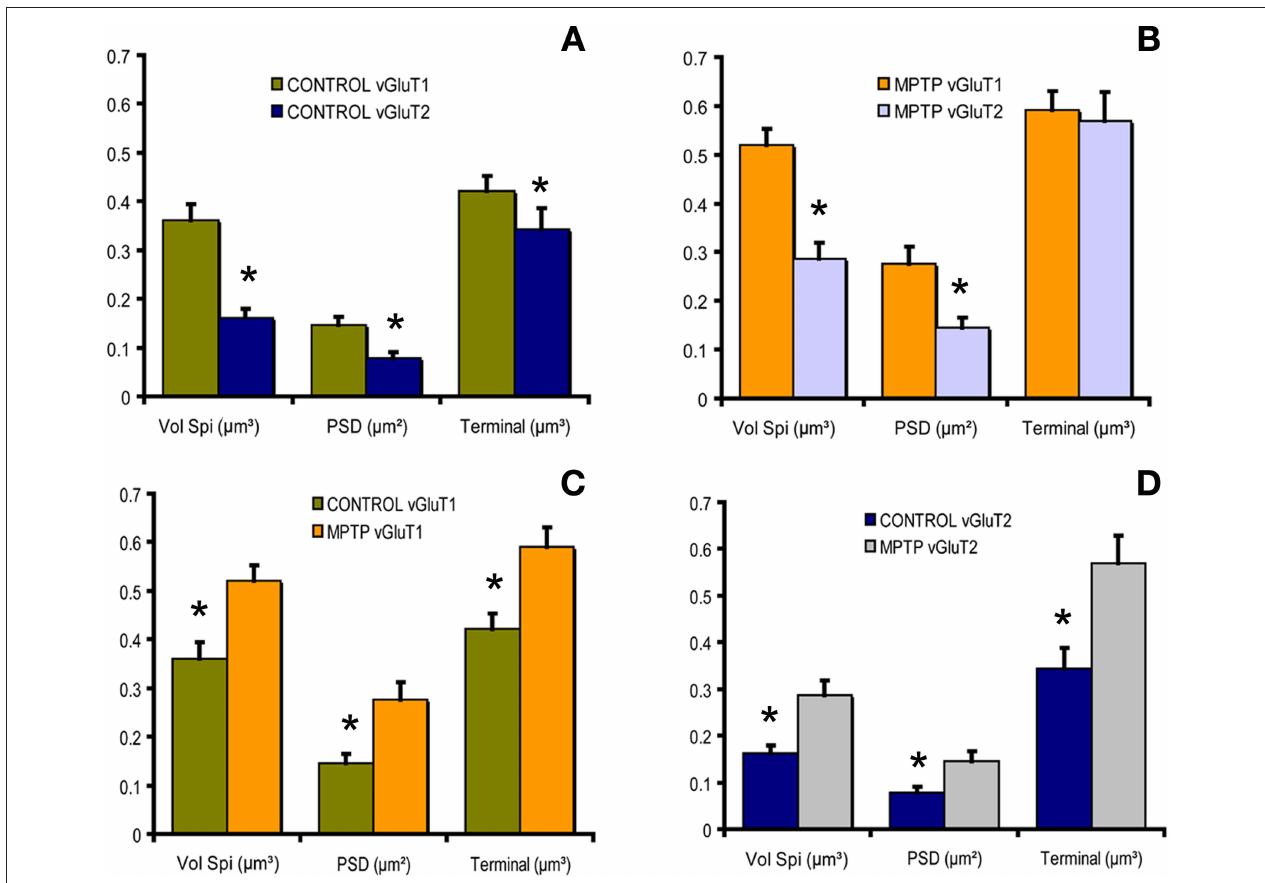
Figure 4 | Histograms comparing the morphometric measurements (spine volume, PSD area, terminal volume) of structural elements at corticostriatal and thalamostriatal glutamatergic synapses using the 3D reconstruction method of serial ultrathin sections collected from 30 axo-spinous synapses in normal and MPTP-treated monkeys. (A) In control monkeys, the spine volume (Vol. Sp), the PSD areas and the size of pre-synaptic terminals at corticostriatal synapses are significantly larger